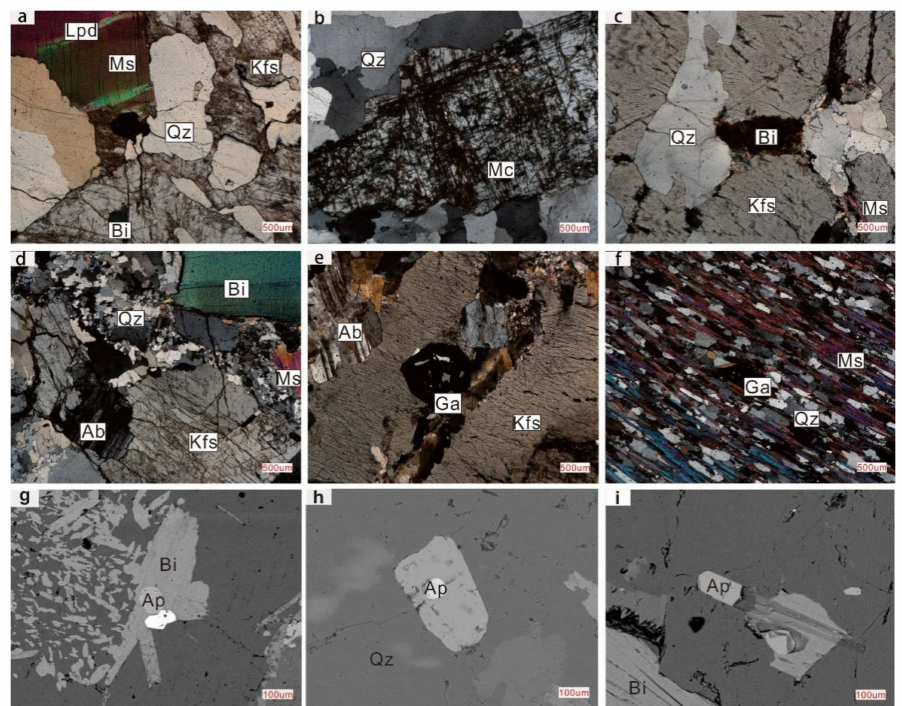
Figure 4. Photomicrographs showing the features of granite and pegmatite from the Renli Nb- Ta deposit: ( a ) lithium mica pegmatite; ( b ) microcline pegmatite; ( c ) two-mica monzogranites; ( d ) beryl pegmatite; ( e ) garnet pegmatite; ( f ) garnet-bearing schist; ( g – i ) BSE images of apatite in pegmatite. Ab = albite; Bi = biotite; Grt = garnet; Kfs = K-feldspar; Lpd = lepidolite; Mc = microcline; Ms = muscovite; Qz =